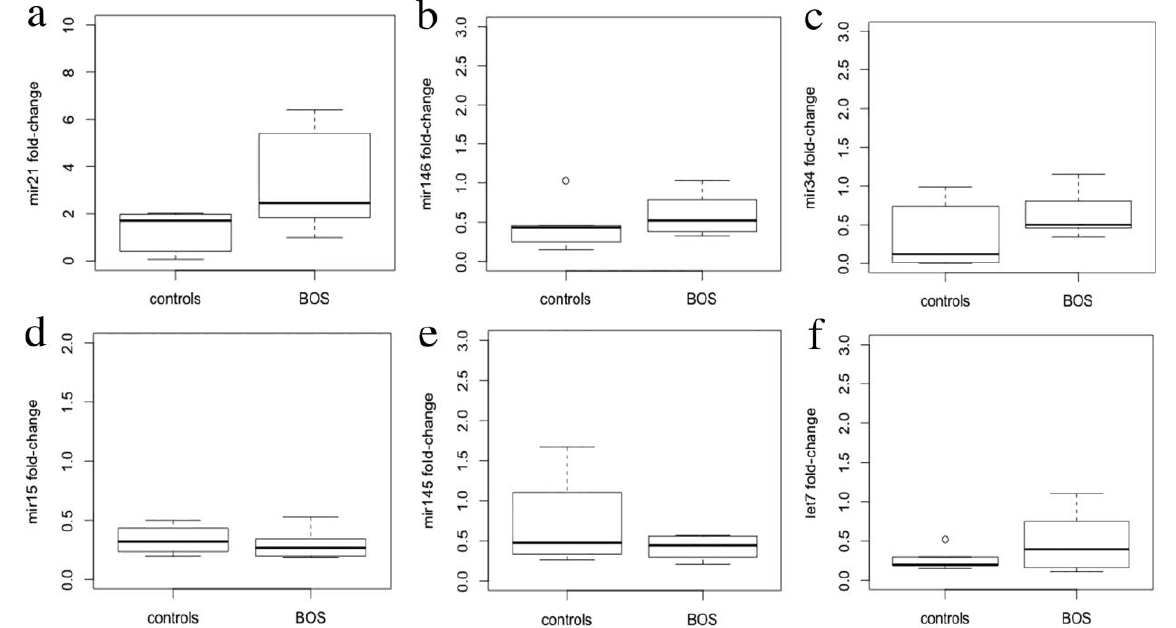
Figure 2. Quantitative analysis of miRNAs expression. qRT-PCR miRNAs expression levels in BOS samples, represented as fold changes relative to RNU6.